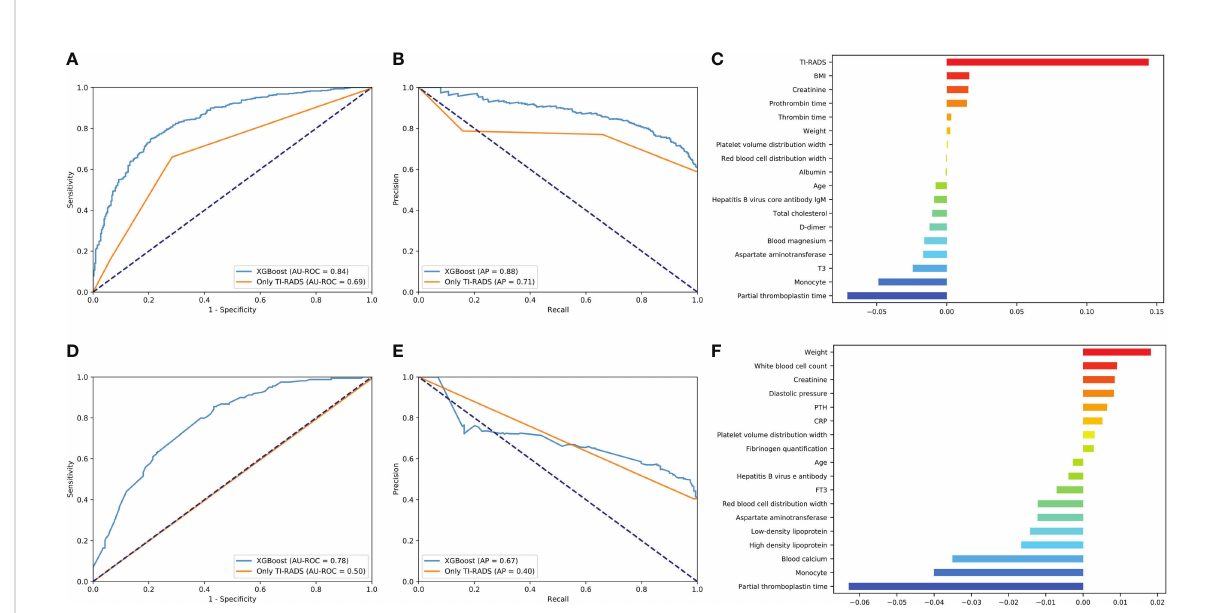
FIGURE 4 Predictive models of evaluation of the benign/malignant nodules of all 4 th category of TI-RADS and only 4th category. (A, D) The average ROC curves from of XGBoost and Only TI-RADS models in the validation sets. (B, E) The average PR curves, indicating the tradeoff between precision and recall. (C, F) The histogram describes the important features of the XGBoost predictive model for benign/malignant nodules of all 4 th category of TI-RADS.